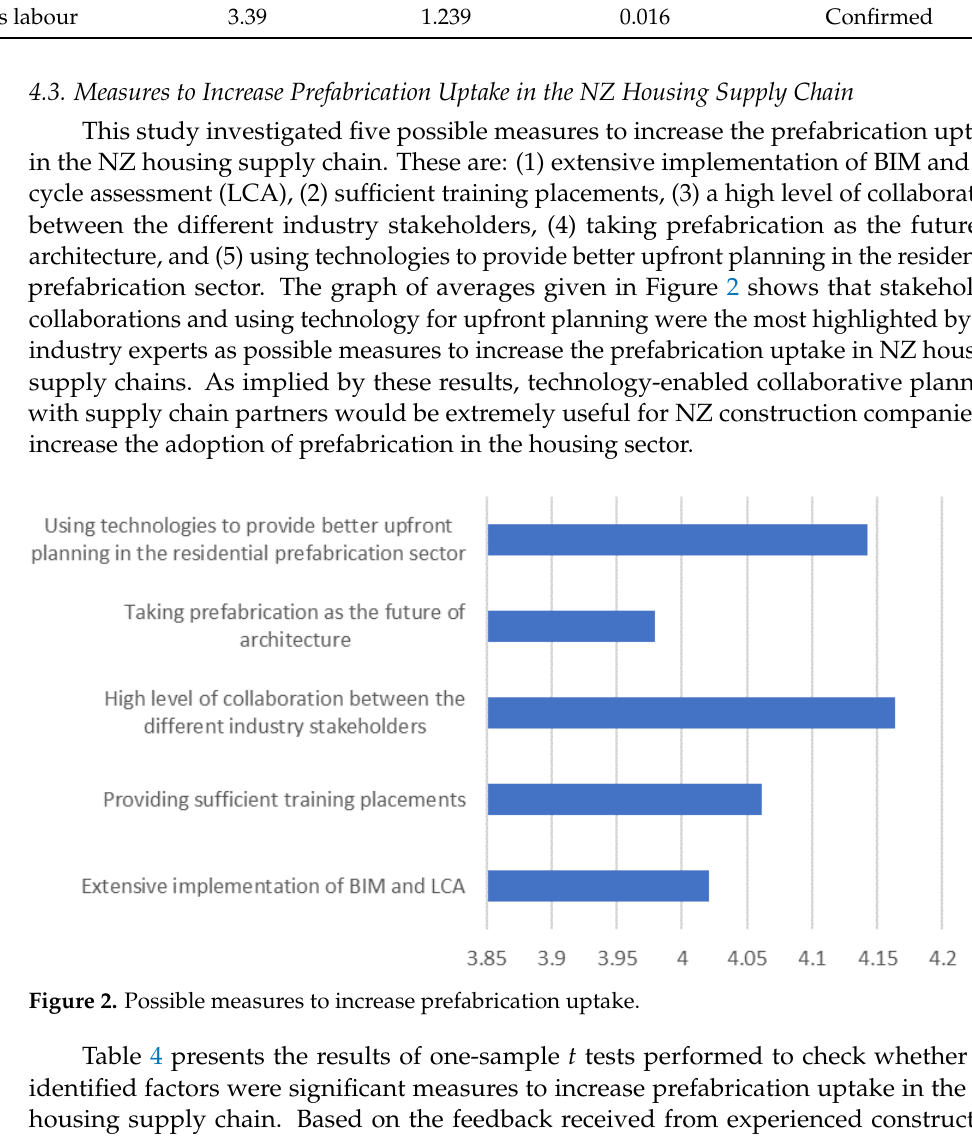
Figure 1. Skill issues in the prefabrication construction industry.